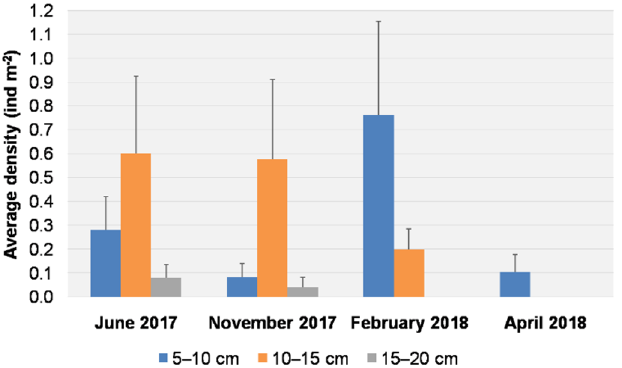
Figure 5. Average density (+S.E. as vertical bar) of Cassiopea andromeda individuals for each size class per sampling date.